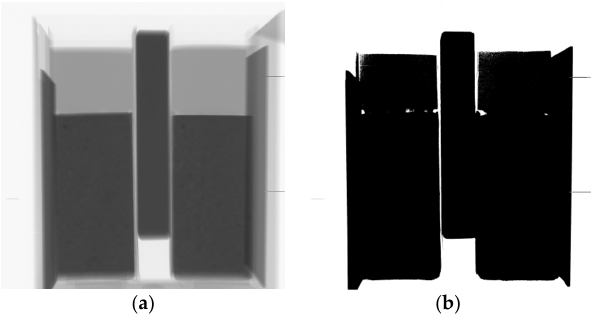
Figure 18. Images from X ‐ ray absorption measurement when water is absorbed by the substrate: ( a ) original; and ( b ) thresholded image.